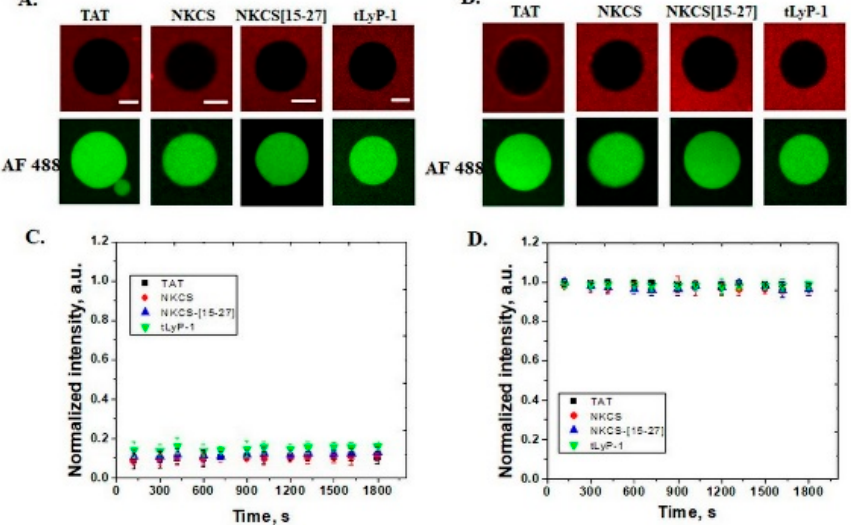
Figure 2. Internalization of peptides and efflux of Alexa Fluor 488 from POPC GUVs. ( A ) Interaction of peptides (TAT, NKCS, NKCS ‐ [15 ‐ 27] and tLyP ‐ 1) with GUVs containing POPC/chol 80/20 mol% after 5 min and ( B ) after 30 min. Neither peptide internalization nor AF 488 efflux can be observed even after 30 min as shown in the graphs ( C ), internalization of peptides (TAT ( ■ ), NKCS ( ● ), NKCS ‐ [15 ‐ 27] ( ▲ ) and tLyP ‐ 1 ( ▼ )) and ( D ), efflux of the fluorescent tracer. Error bars indicate the standard deviation. Scale bars correspond to 20 μ m.